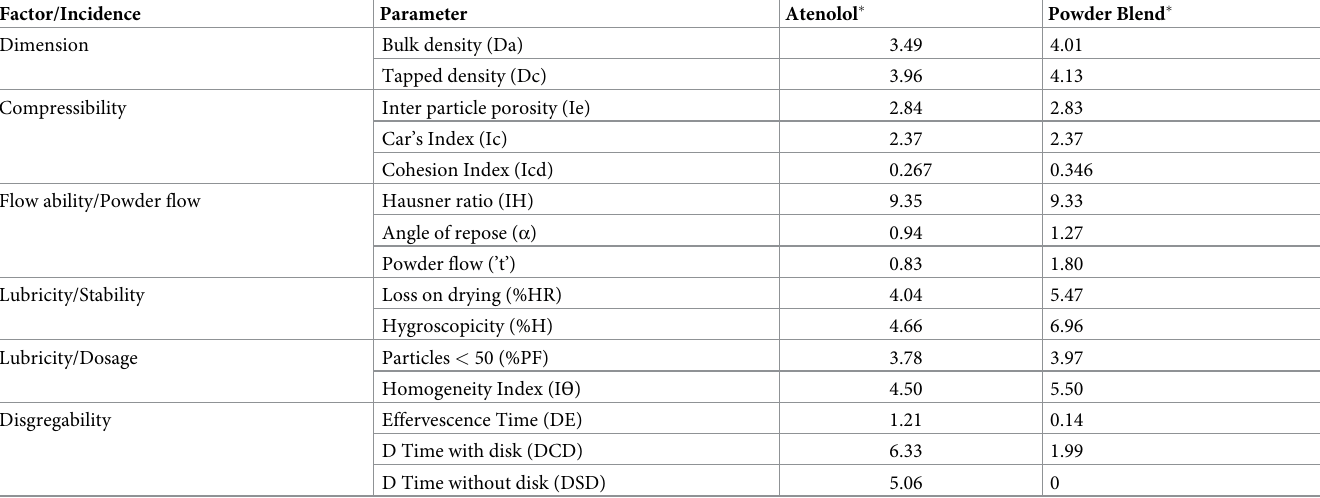
Table 4. Characterization of atenolol powder and its blend with other excipients on the basis of SeDeM-ODT expert